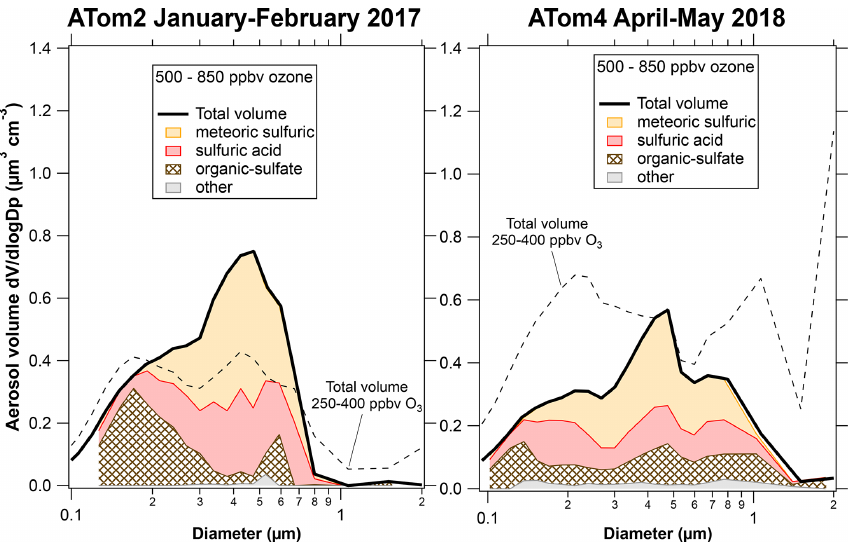
Figure 3. Composition-resolved size distributions for the times when data are available for ozone greater than 500ppbv, all in the Northern Hemisphere. The dashed curves are to facilitate comparison with Fig. 1.